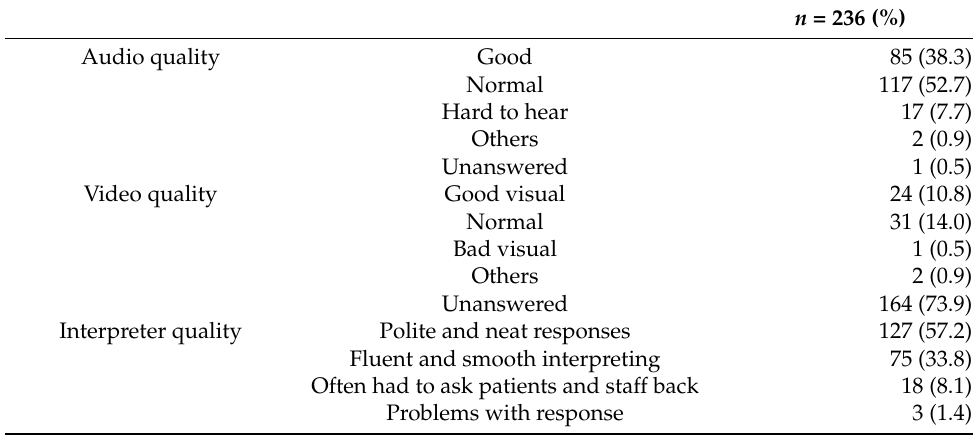
Table 5. Evaluation of remote medical interpreting by healthcare providers.